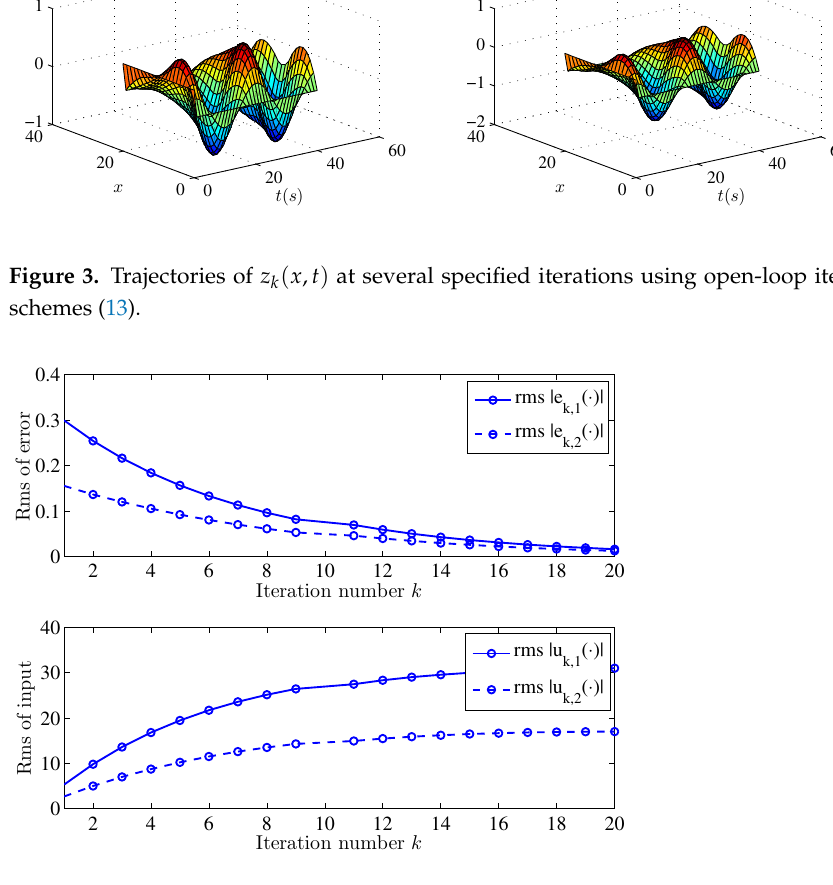
Figure 4. Trajectories of inputs | u k , i ( t ) | and output errors | e k , i ( t ) | using open-loop iterative learning schemes